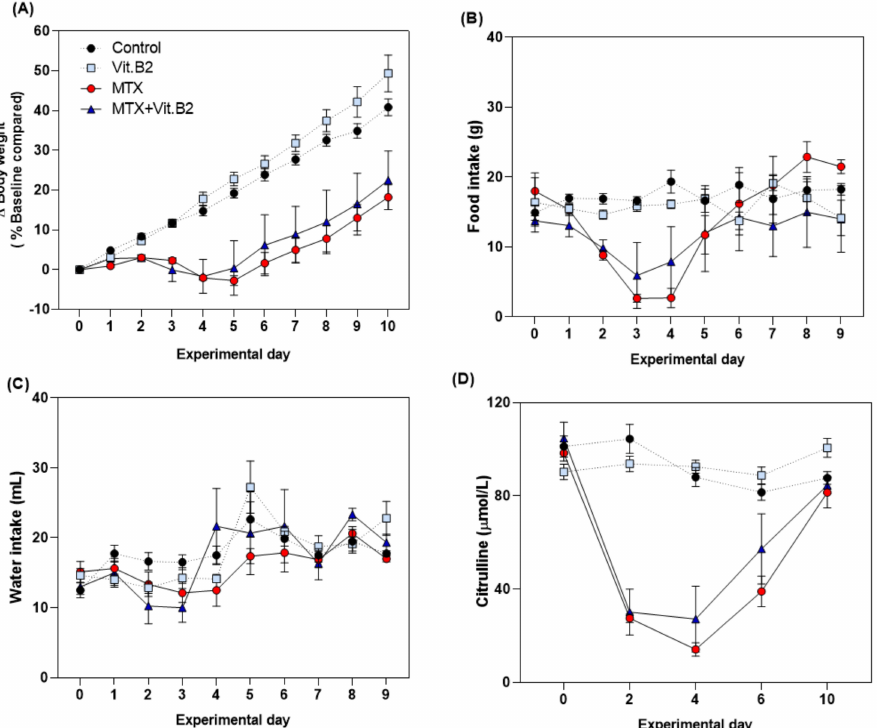
Figure 4. Effects of vitamin B2 (12 mg/day/rat) on the clinical parameters. ( A ) Bodyweight relative to weight at day 0, which was set at 100%. ( B ) Food intake in grams per day. ( C ) Water intake in ml per day. ( D ) Plasma citrulline level ( µ mol/L) measured at days 0, 2, 4, 6 and 10 after MTX injection. All data are presented as mean ±